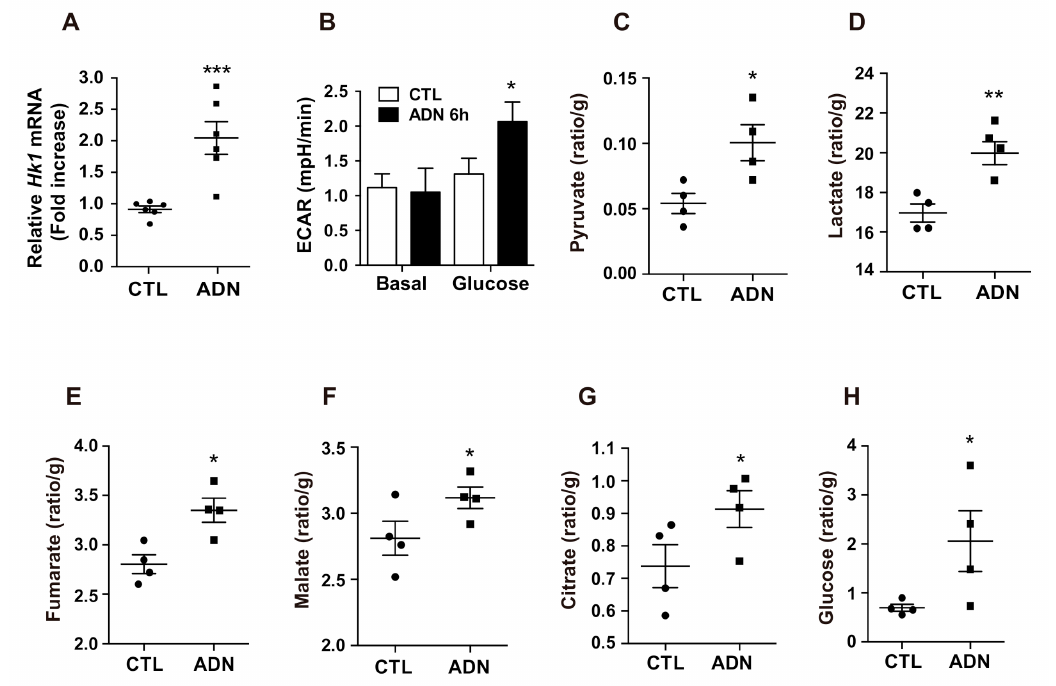
Figure 3. Adiponectin enhances glycolytic activity in primary astrocytes. Primary astrocytes were seeded at 5 × 10 5 cell/well, starved overnight, and treated with adiponectin (ADN, 1 µ g/mL) for 24 h. ( A ) The level of mRNA encoding hexokinase 1 (Hk1) was upregulated in adiponectin-treated primary astrocytes compared to that in vehicle-treated primary astrocytes as determined by qRT-PCR ( n = 6 for each group). ( B ) The extracellular acidification rates (ECAR) were elevated by adiponectin treatment ( n = 3 for each group). GC-MS results showed increased levels of ( C ) pyruvate, ( D ) lactate, ( E ) fumarate, ( F ) malate, ( G ) citrate, and ( H ) glucose in the hypothalamus of adiponectin-treated mice compared with that of vehicle-treated mice ( n = 4 for each group). Results are presented as the means ± SEM. qPCR and ECAR experiments were performed from at least three different preparations of astrocytes. * p < 0.05; ** p < 0.01; *** p <